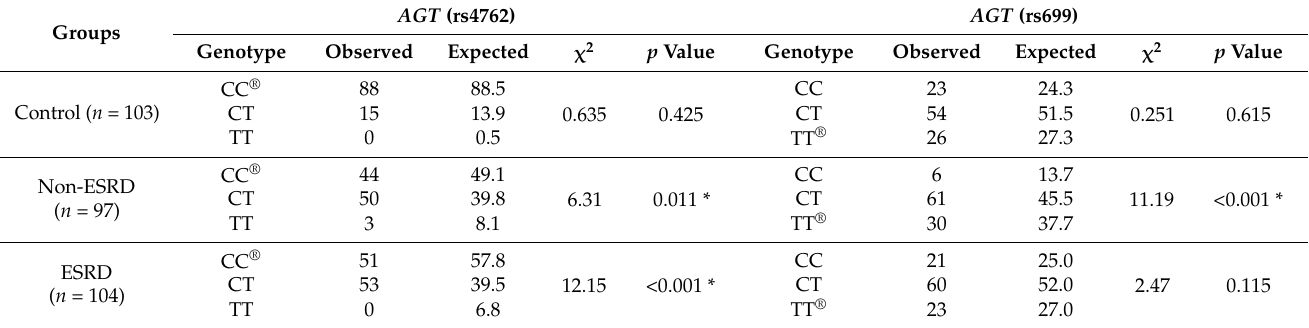
Table 3. Hardy–Weinberg equilibrium for AGT gene (rs4762 and rs699) genotypes among patient groups and controls. Groups